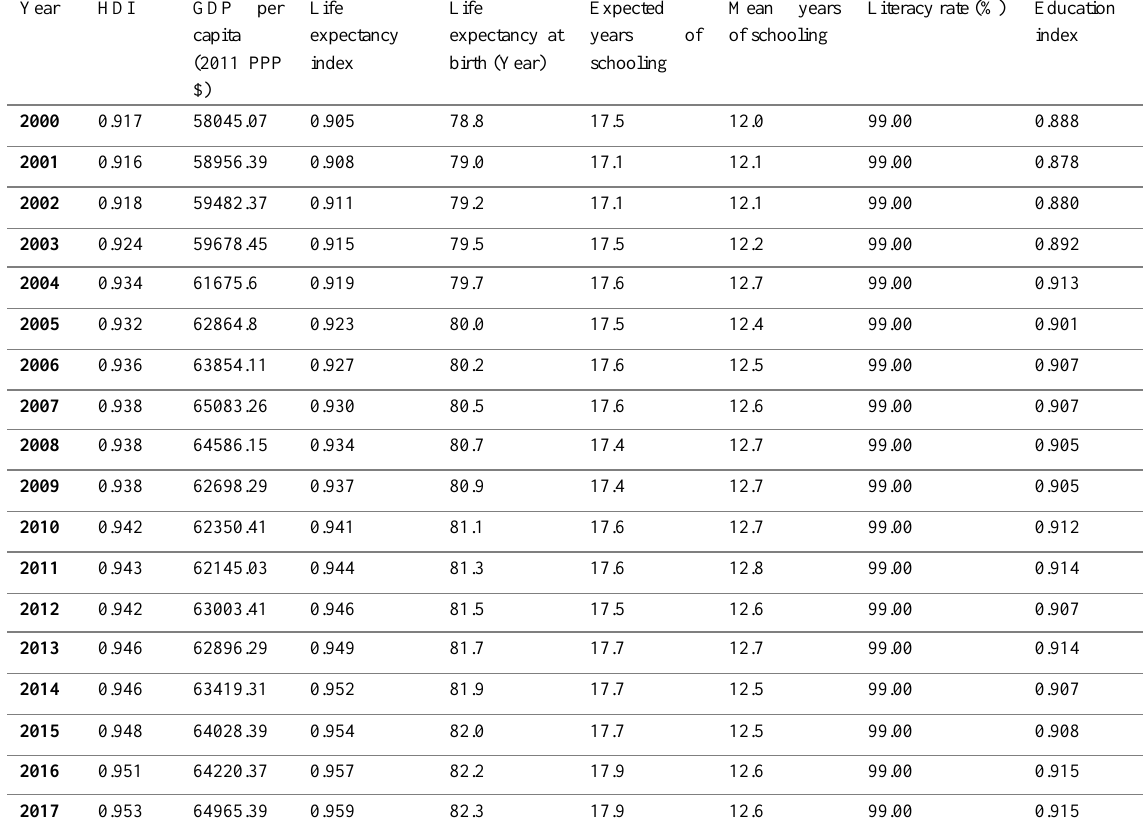
Table 5: Norway’s Human Development